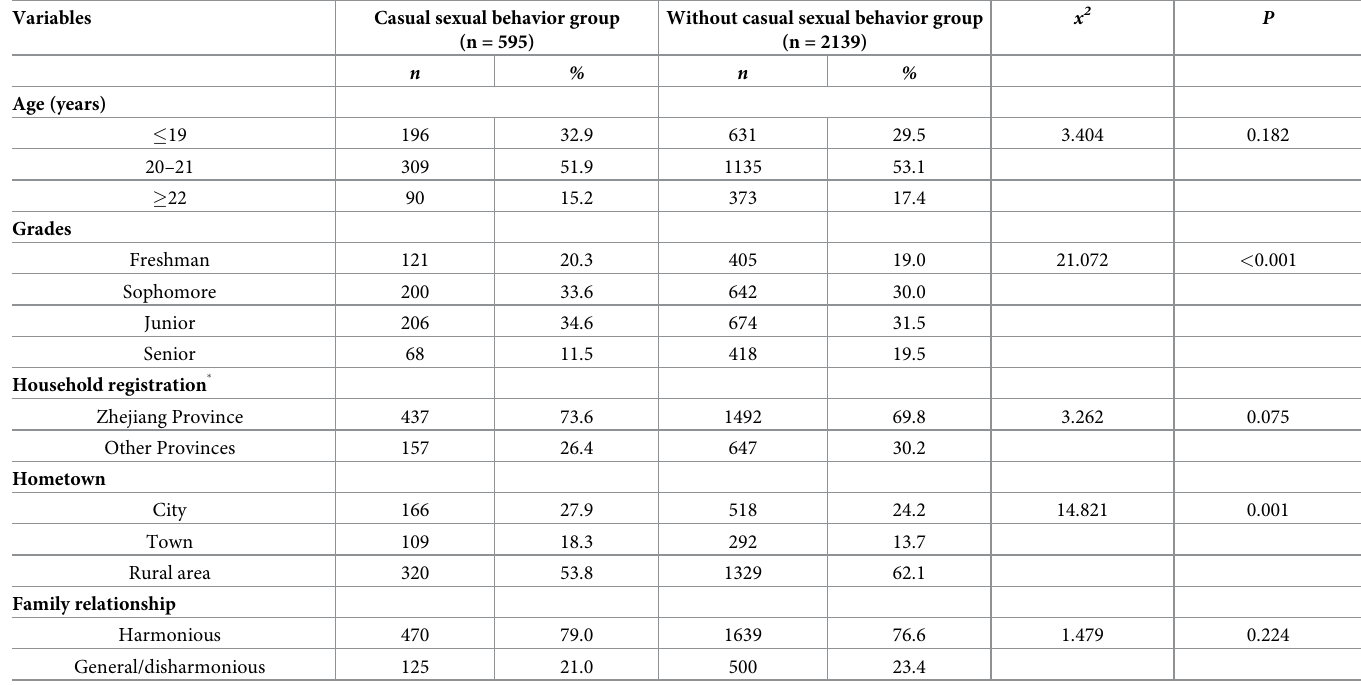
Table 1. Demographic characteristics of 2734 male college students.